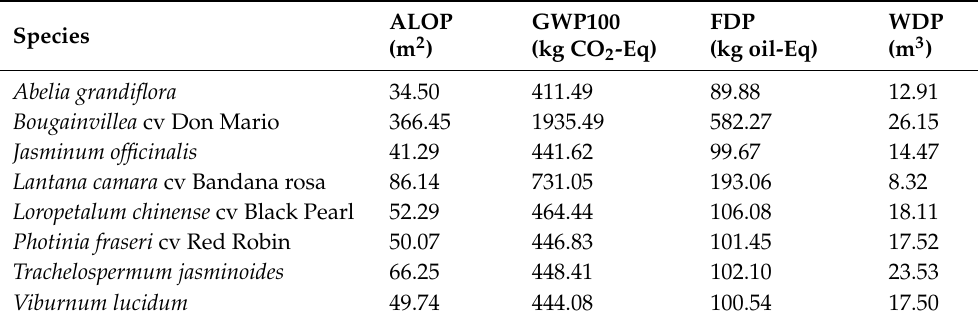
Table 7. Environmental implications associated with conventional production model (CM) among 8 selected ornamental species of 1000 plants.